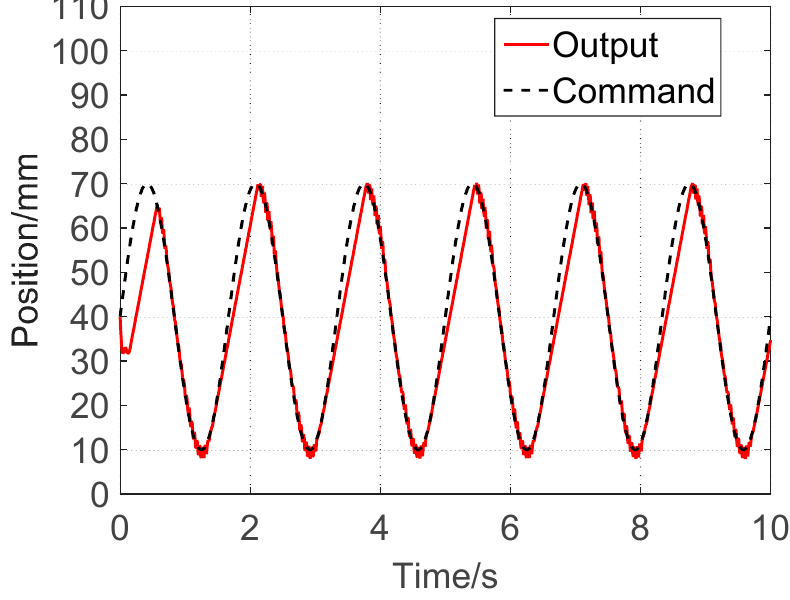
Figure 28. The simulation result after the controller parameters are modified. By comparing Figure 28 with Figure 27f, although Figure 27f shows good robustness of the controller, a better control effect can be achieved in the positive half cycle of the sine command after controller parameter correction. Figure 29a,b show the experimental results using the delay compensation control method, with the same command of Figure 18a,b, respectively. In Figure 29a, the propor- tional coefficient is 20 and the k f = 250, while in Figure 29b, the proportional coefficient is 10 and the k f = 125. The experimental results show that the delay compensation control method can strengthen the tracking performance of the BHL-EHA system and completely compensate for the amplitude difference of sinusoidal control; the amplitude of the position output is even 3% higher than the command